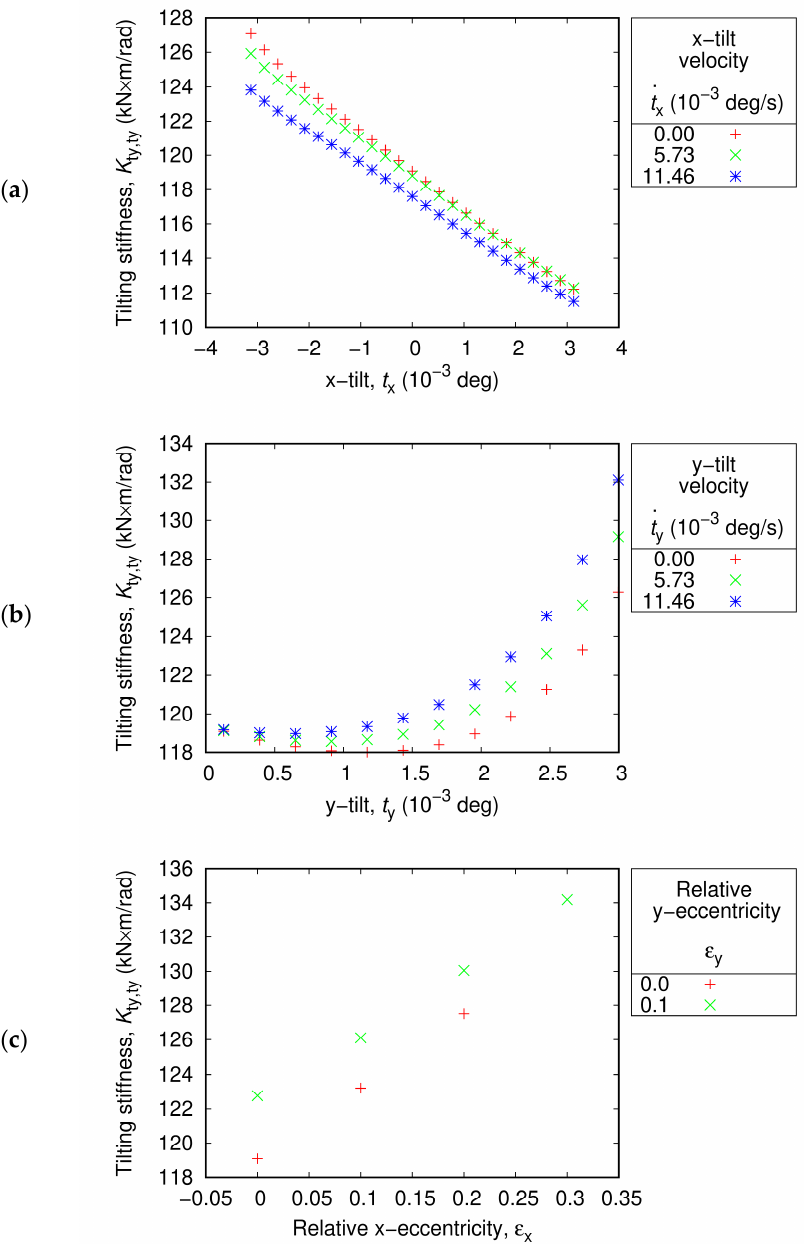
Figure 7. Parameter sensitivity of the direct stiffness coefficient K ty , ty : ( a ) Effects of the tilting angle and tilting velocity in the x-direction; ( b ) Effects of the tilting angle and tilting velocity in the y-direction; ( c ) Effects of relative eccentricities. All unreferenced parameters have zero values.